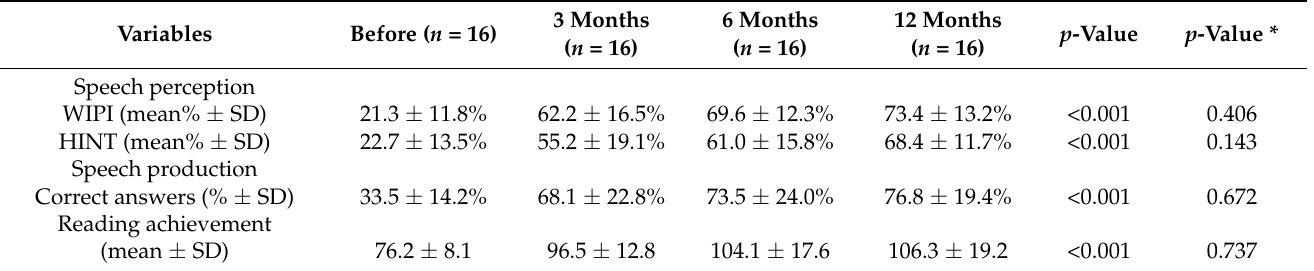
Table 3. Adult patients’ hearing assessment at follow-up.